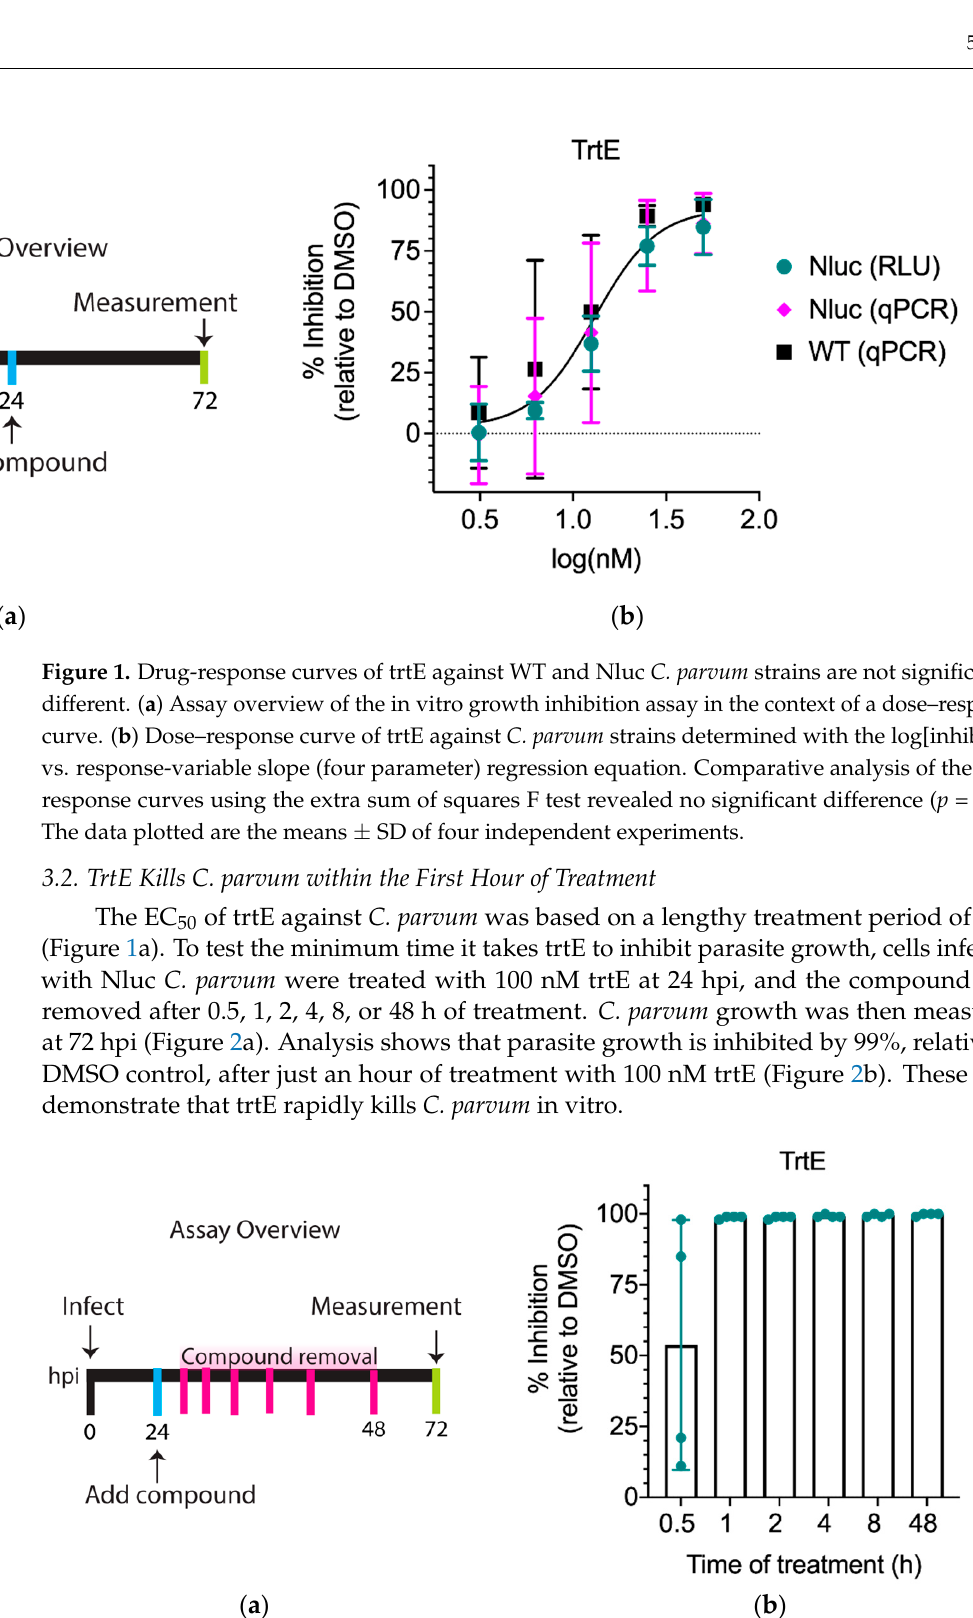
Figure 2. TrtE rapidly kills Cryptosporidium. ( a ) Overview of the inhibition growth assay when testing the time it takes a compound to kill the parasite. ( b ) Graph shows the percent inhibition of trtE treatment relative to DMSO control. The data plotted are the mean ± SD of four independent